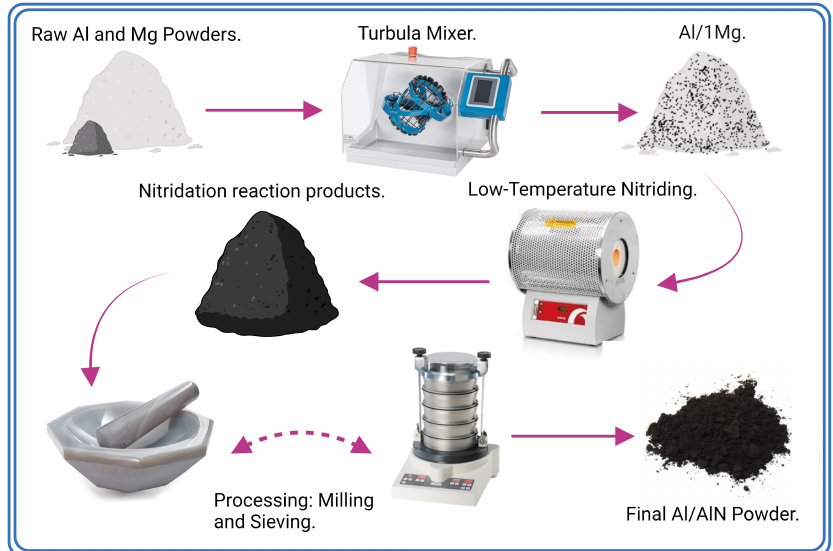
Figure 3. Schematic flowchart showing the processing steps used to nitride the loose Al powder to obtain the final nitride powders: Al/Mg powder blending, low-temperature nitriding and processing via mortar and pestle, (iterative to achieve ensure homogeneity in particle size, ≤ 63 µ m). Microstructure